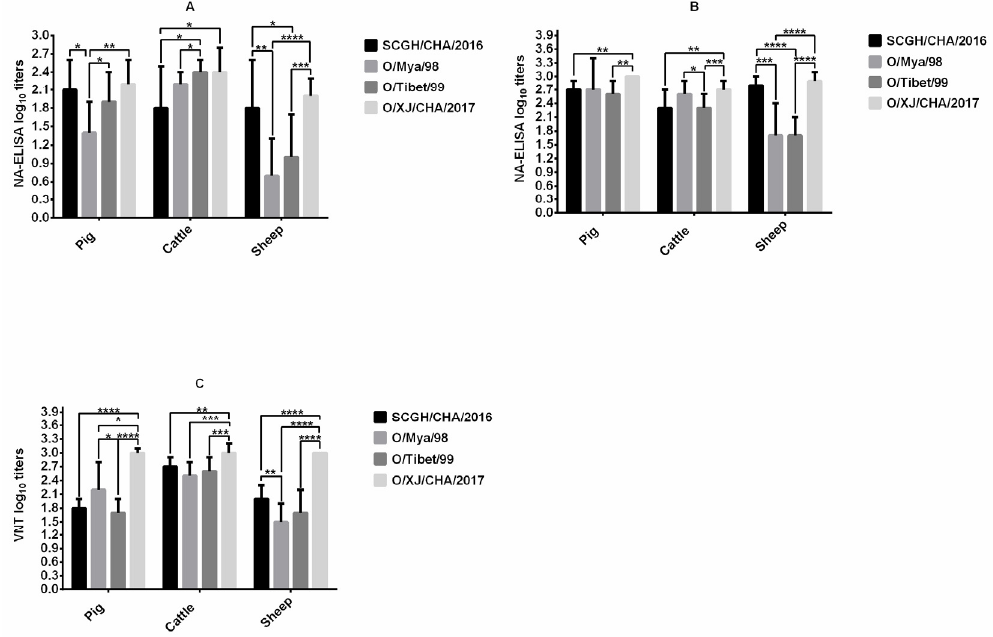
Figure 1. Comparison of immunogenicity in pigs, cattle, and sheep. Pigs (10 animals for each strain), cattle (12–13 animals for each strain) and sheep (12–13 animals for each strain) were immunized with Foot-and-mouth disease virus (FMDV) O/Mya/98, SCGH/CHA/2016, O/Tibet/99, and O/XJ/CHA/2017 vaccines at day 0 and 21, respectively. Serum samples collected at 21 days post vaccination (dpv) were used to measure homologous antibodies by NA-ELISA ( A ) and serum samples collected at 42 dpv with boosted vaccination were used to measure homologous antibodies both by NA-ELISA ( B ) and virus neutralizing test (VNT) ( C ). The statistical significance of differences between groups was determined. * p < 0.05, ** p < 0.01, *** p < 0.001, **** p < 0.0001.